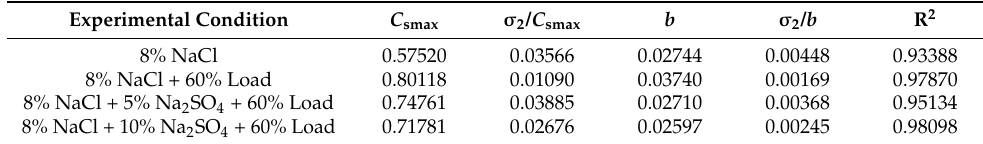
Figure 5. C s of concrete immersed in different sodium sulfate and sodium chloride coupling of the cyclic loading condition. Table 4. C s exponential model fitting experimental results.